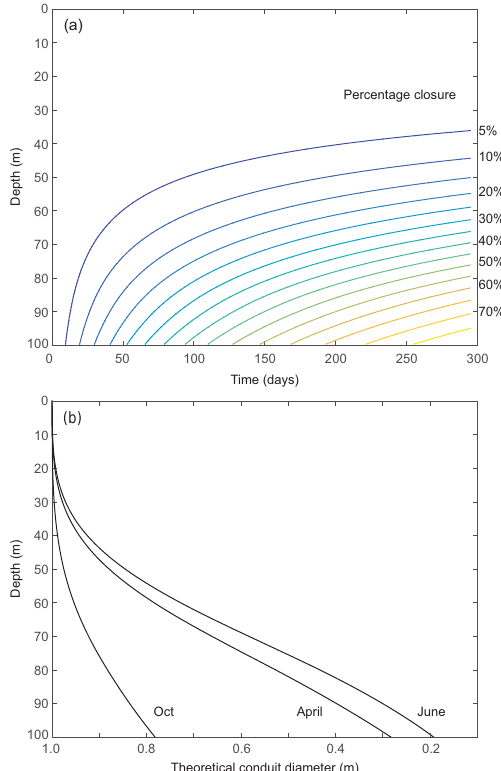
Figure 9. (a) Contour plot of the theoretical percentage closure for a hydrologically inactive englacial channel within Austre Brøgger- breen over time; (b) illustration of the theoretical channel dimen- sions for the englacial conduit assuming a 1m diameter at the end of the hydrologically active season (September) for the October and April survey dates, and for the resumption of the melt season